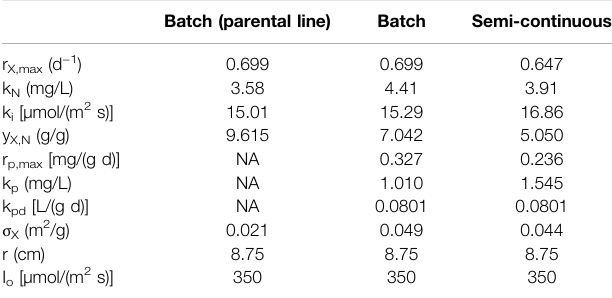
TABLE 1 | Estimated kinetic parameters for batch, fed-batch and semi- continuous model of an MFHR1 producer line (Line B, MFHR1 I62 ). r X,max : maximum speci fi c growth rate. k N and k i : saturation constants of the limiting substrates, nitrate and light, respectively. y X,N : biomass yield coef fi cient. r p,max : maximum speci fi c recombinant protein production rate. k p : nitrate saturation constant for recombinant protein synthesis. k pd : speci fi c protein degradation